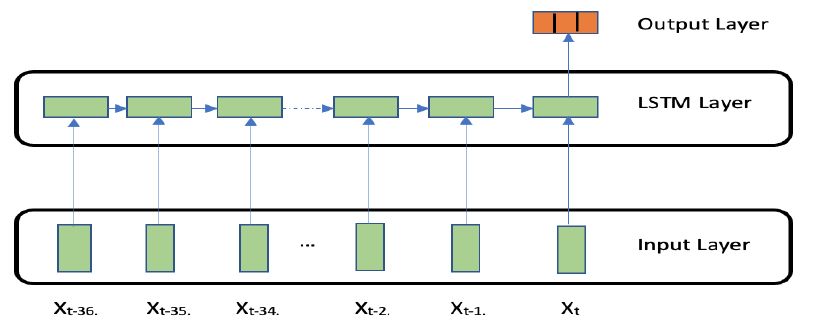
Figure 3. The general architecture of the proposed LSTM networks implemented for both the precipitations and temperatures